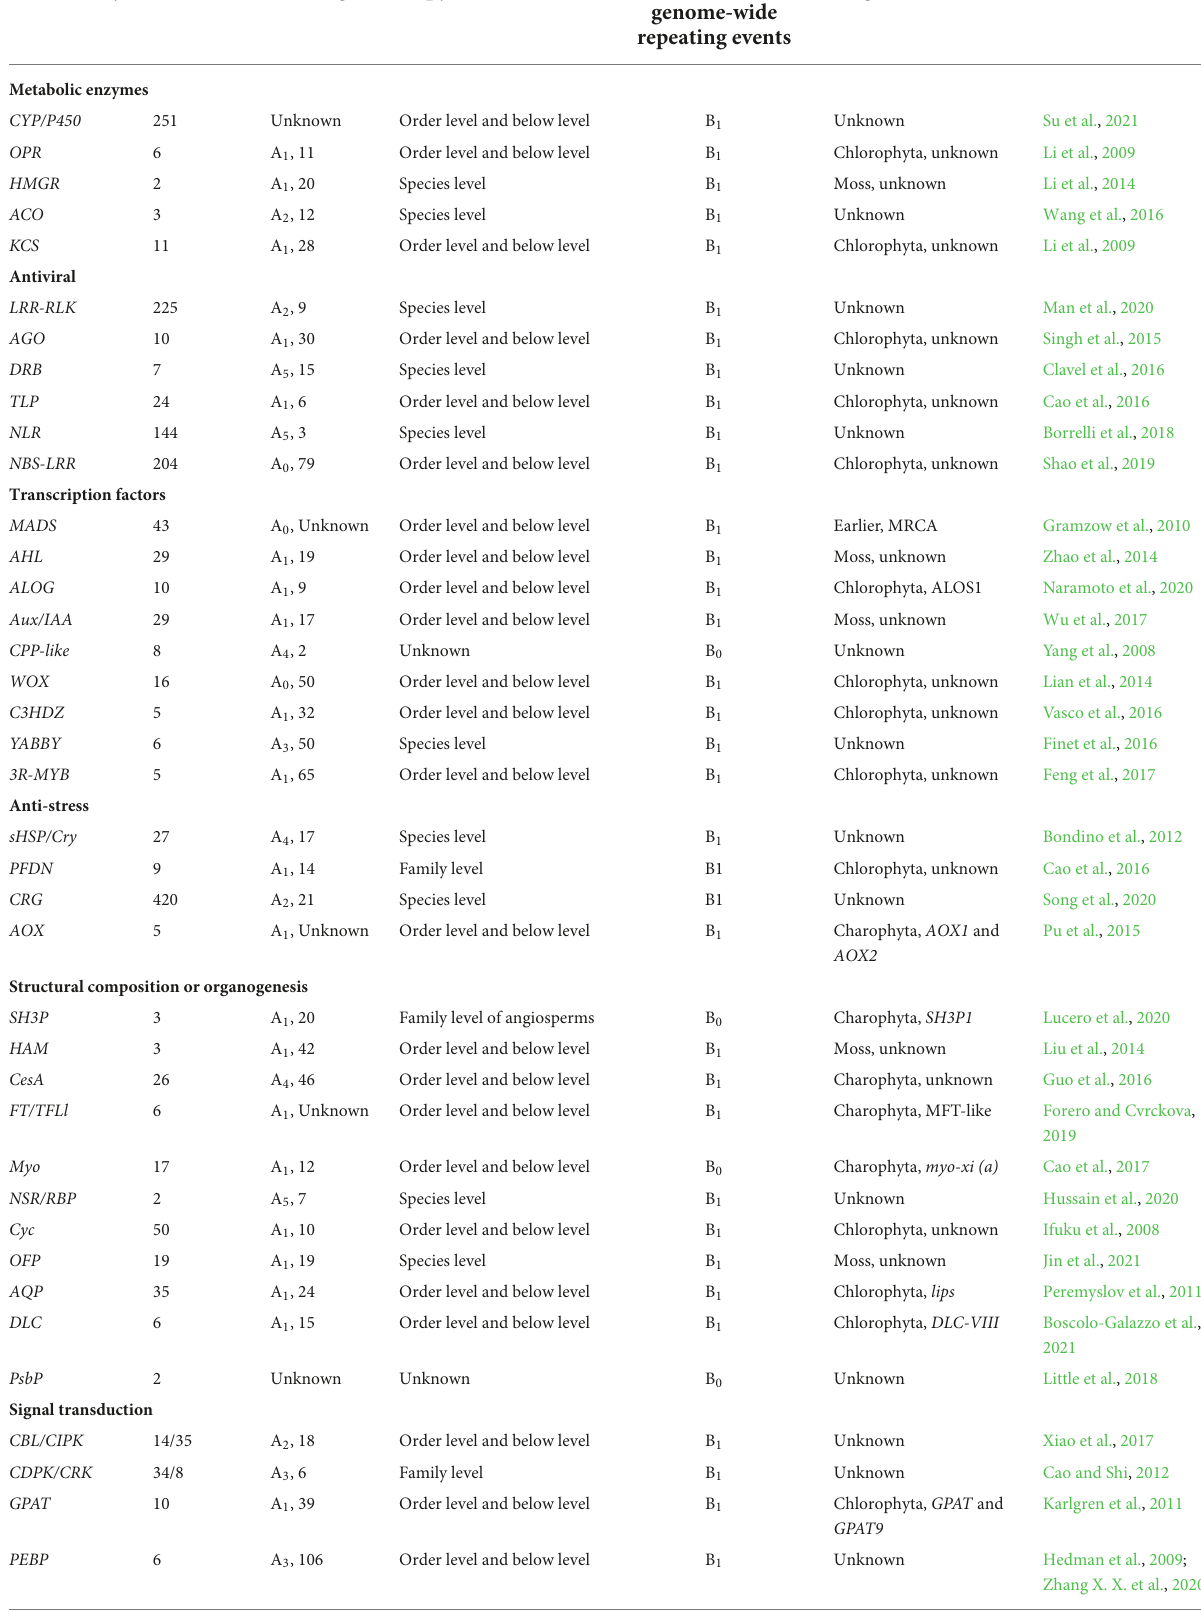
TABLE 2 Evolutionary events of plant protein-coding gene